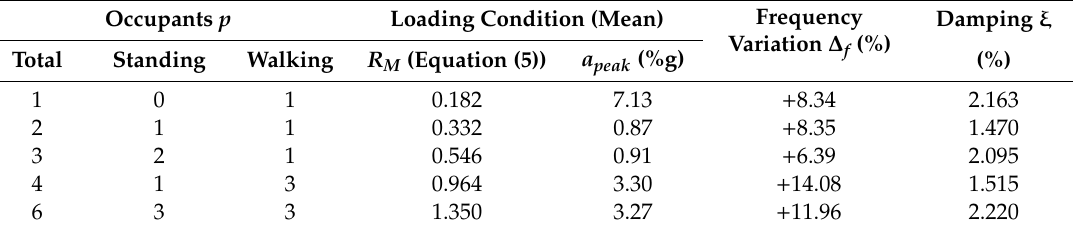
Table 3. Average frequency variation and damping for the system